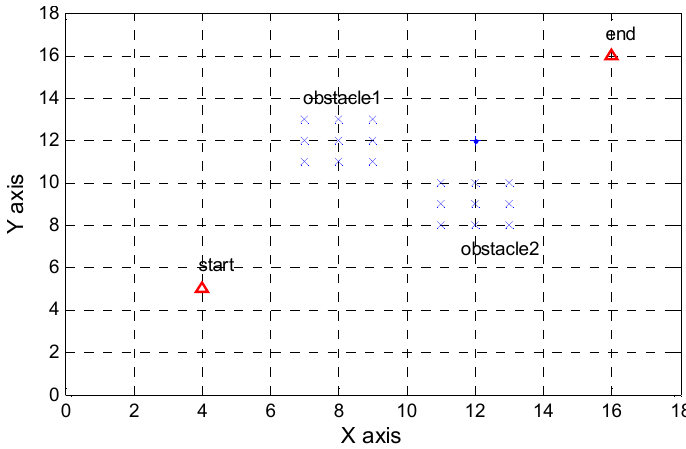
Figure 5. Obstacle map for path planning.